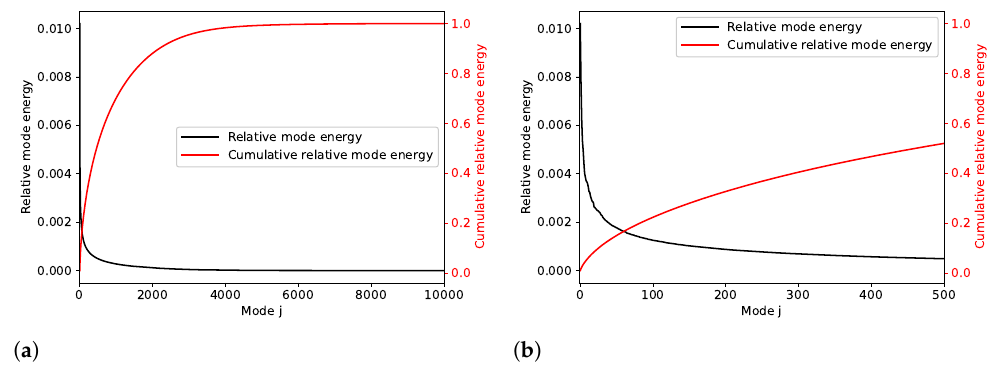
Figure 9. Relative contribution of the POD eigenvalues in the overall turbulent kinetic energy. ( a ) All eigenvalues. ( b ) Zoom on the first 500